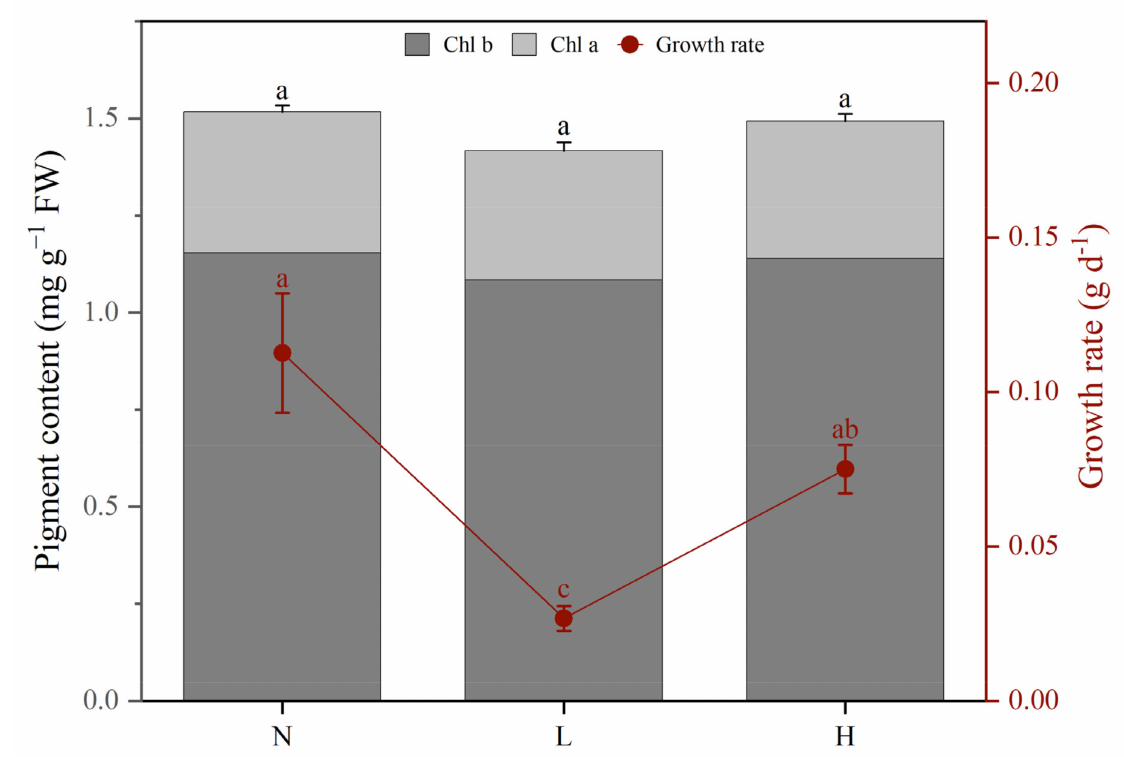
Figure 1. The growth rate and chlorophyll a and b pigment content of Myriophyllum aquaticum under different phosphorus concentrations. N, normal phosphorus concentration treatment (0.25 mM); L, low phosphorus concentration treatment (0.02 mM); H, high phosphorus concentration treatment (5 mM). Different lowercase letters above the error bars in the same color mean significant differences, and bars sharing the same letter are not significantly (Turkey’s